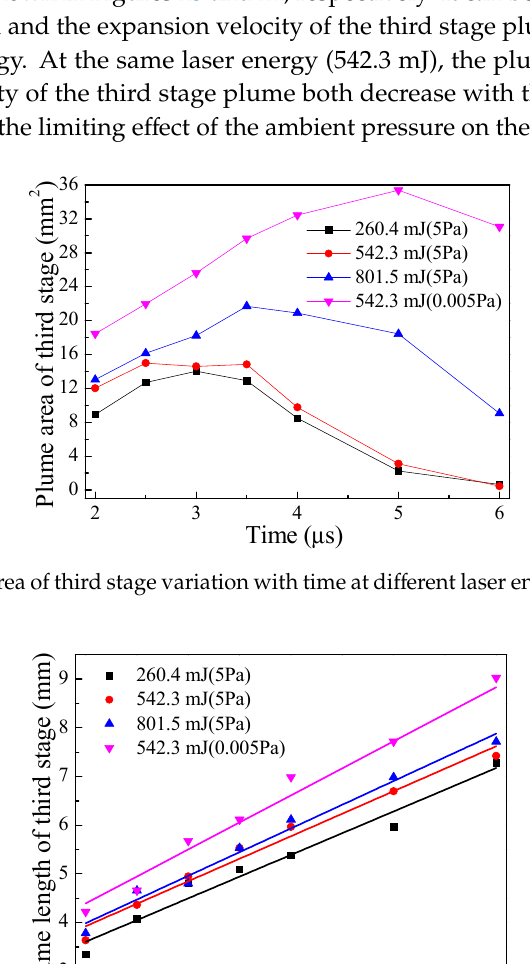
Figure 22. The total area of initial plume variation with time and its fitting curve at different laser energies (ambient pressure 5 Pa and 26.5% Al).